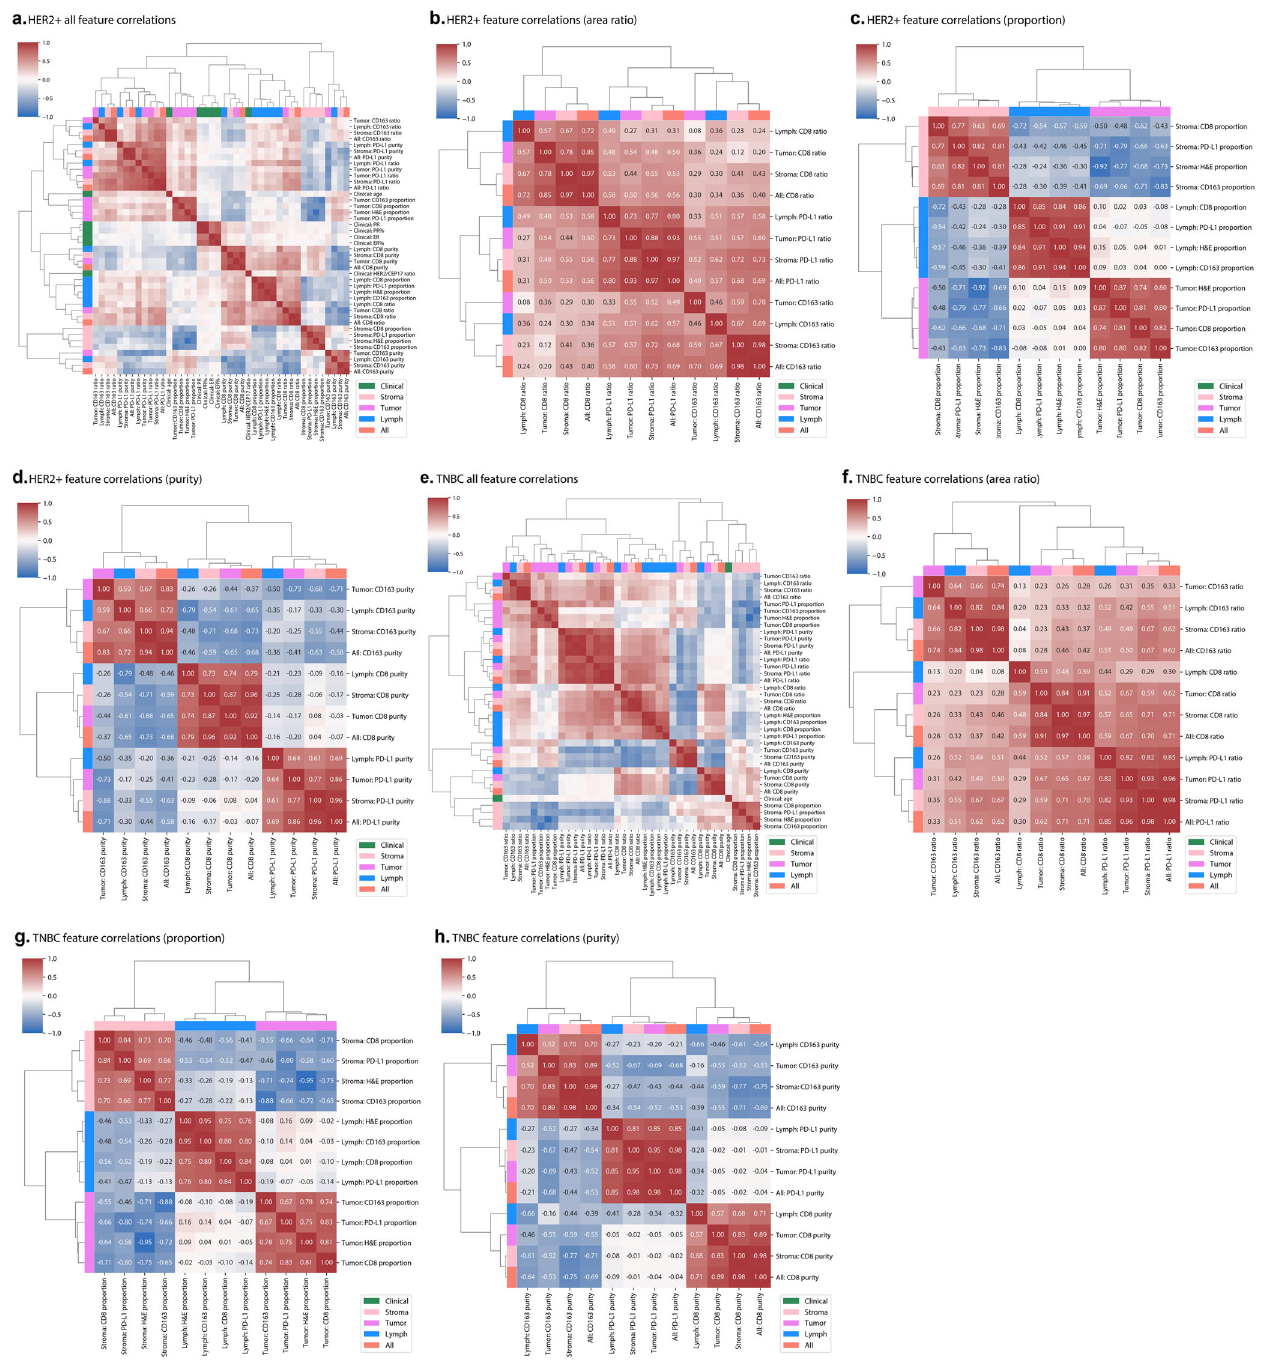
Fig. 5 Correlation analyses for IMPRESS features in HER2 + and TNBC cohorts. a HER2 + all IMPRESS feature correlation matrix; b HER2 + area ratio correlation matrix; c HER2 + proportion correlation matrix; d HER2 + purity correlation matrix; e TNBC all IMPRESS feature correlation matrix; f TNBC area ratio correlation matrix; g TNBC proportion correlation matrix; h TNBC purity correlation matrix. Figure best viewed in purity ( ρ = − 0.79, P -value = 1.96e-14); Stroma: CD163 purity and All: CD8 purity ( ρ = − 0.73, P -value = 1.05e-11); Tumor: CD163 purity and Tumor: PD-L1 purity ( ρ = − 0.73, P -value = 2.46e-11). In TNBC (Fig. 5h), the most negatively correlated purity statistics from different IHC markers were Stroma: CD163 purity and Stroma: CD8 purity ( ρ = − 0.77, P -value = 7.85e-14); Stroma: CD163 purity and All: CD8 purity ( ρ = − 0.75, P -value = 7.18e-13). The results of purity